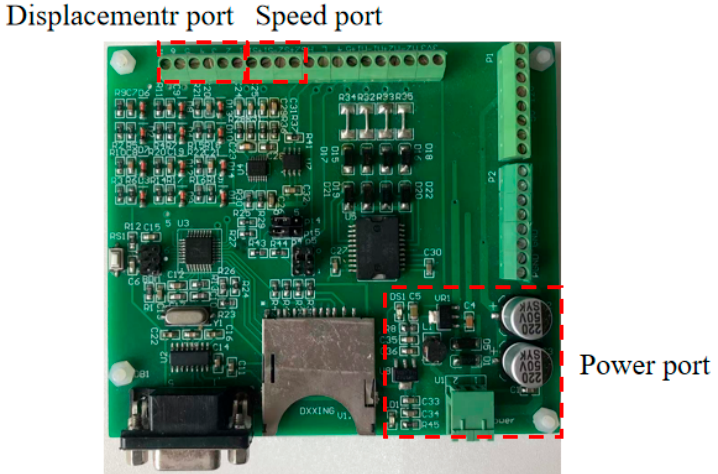
Figure 4. Main fuel regulation control system in the radiation test.